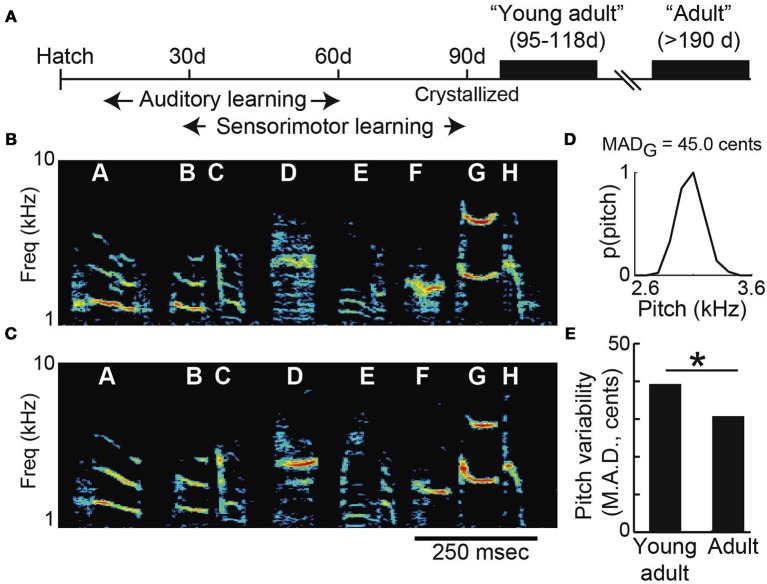
Vocal variability decreases across early adulthood. (A) Timeline of song development. Songbirds learn their songs by a process of vocal imitation. By 90 days of age, the basic acoustic elements of song have been acquired (“crystallized”). Spectrograms show songs recorded from the same Bengalese finch as a young-adult (B; 103 days of age) and later as an adult (C; 353 days). Spectrograms show the power (color scale) at each acoustic frequency as a function of time. (D) The pitch of syllable “G” in (B) is variable, with a median absolute deviation (MAD) of 45.0 cents (see Methods). (E) Young-adult song syllables are significantly more variable than those of older adults (n = 34 syllables from young-adults; n = 102 syllables from older adults; asterisk p < 0.05 Komolgorov-Smirnov test).